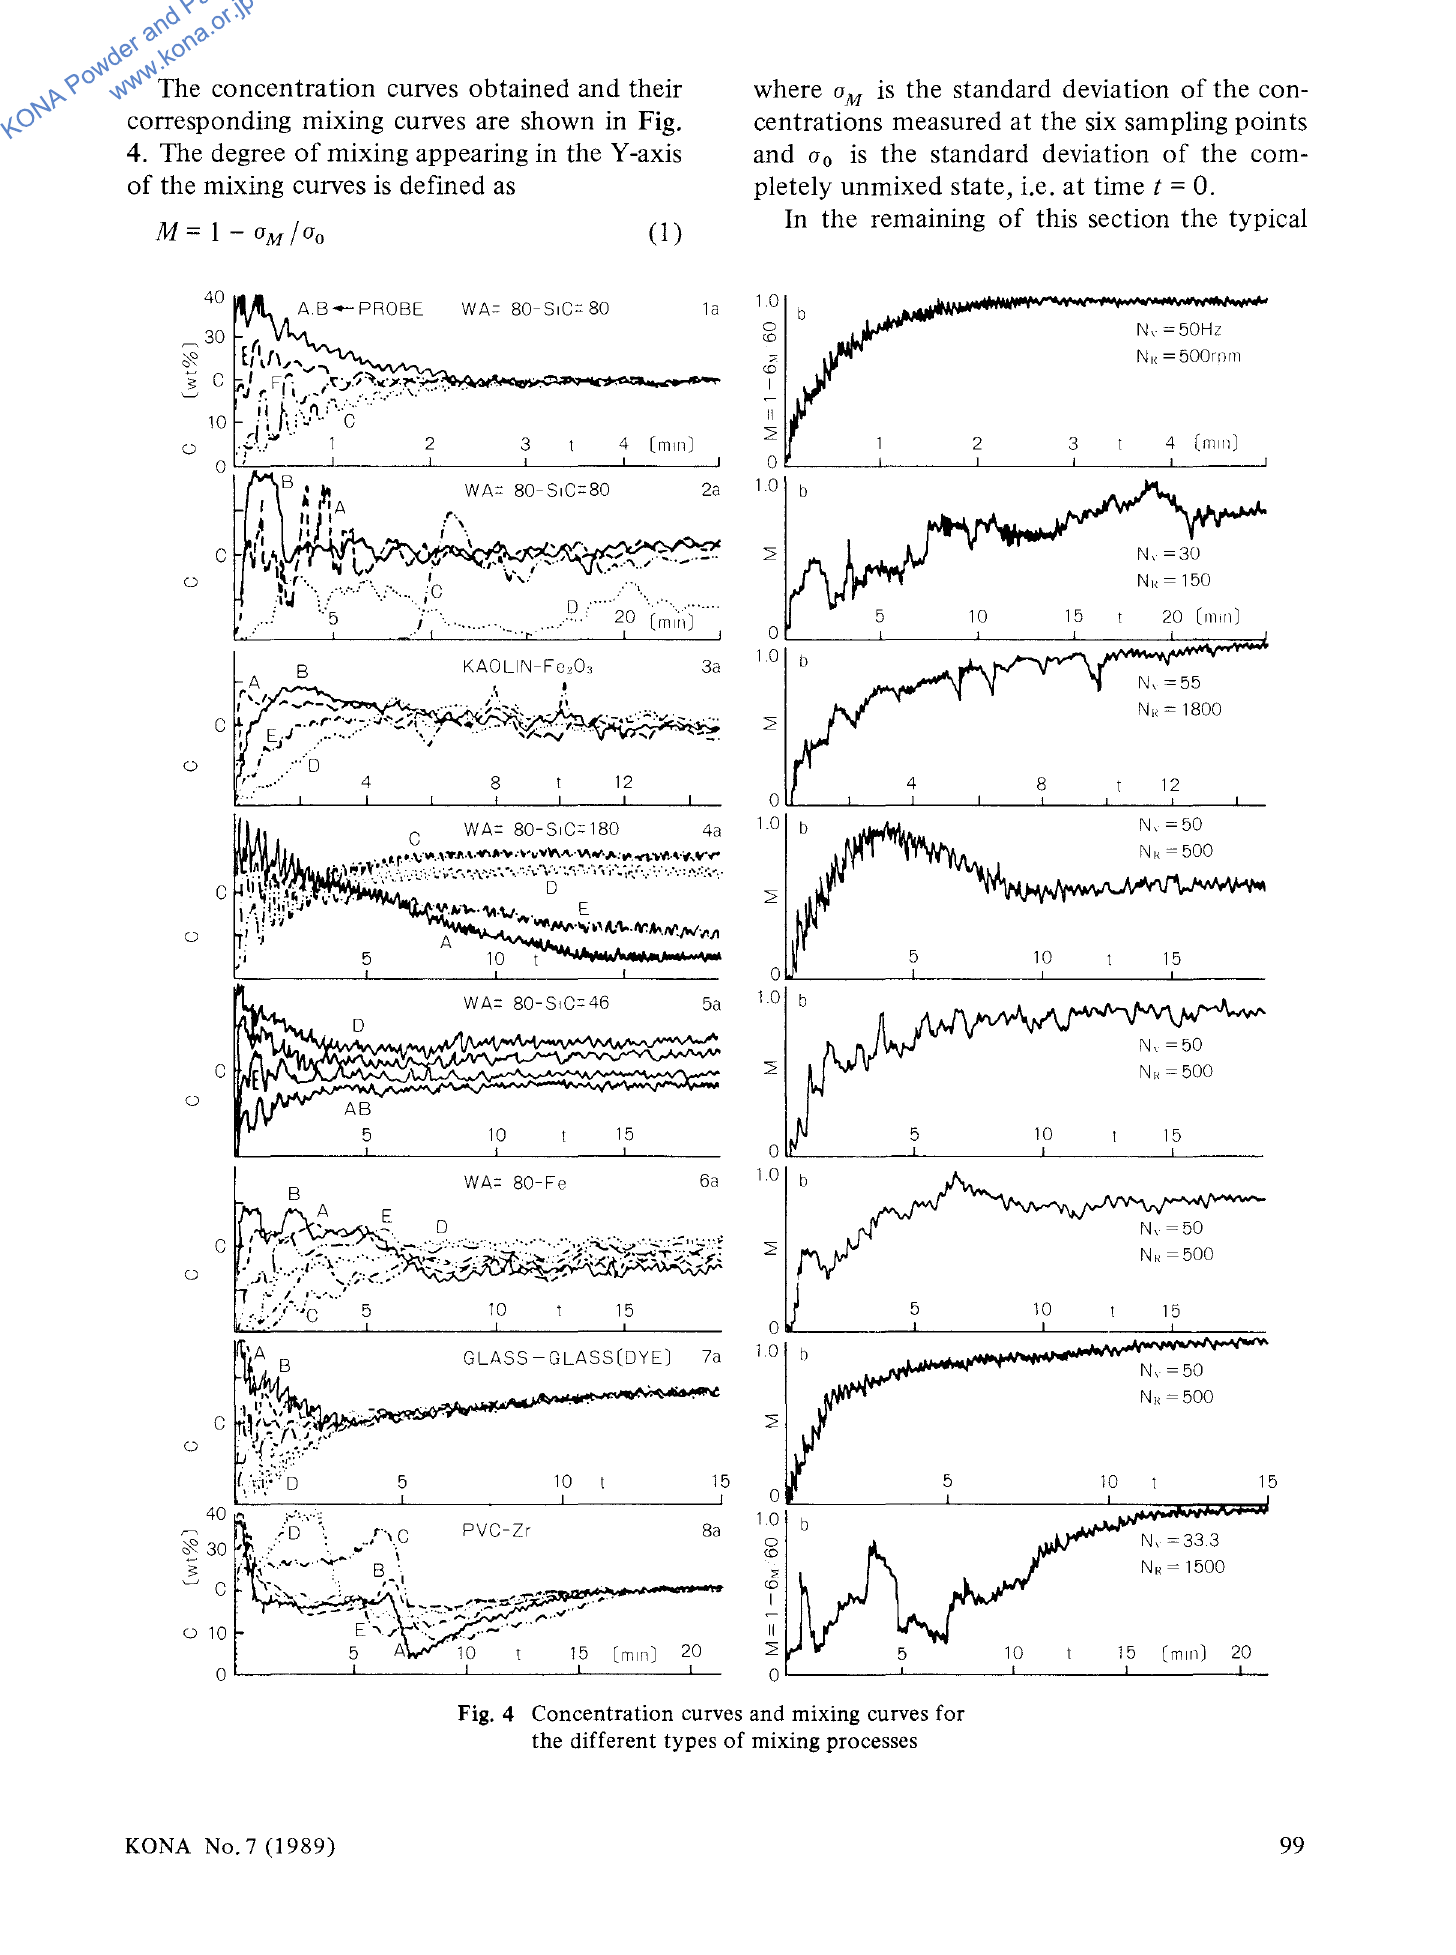
Fig. 4 Concentration curves and mixing curves for the different types of mixing